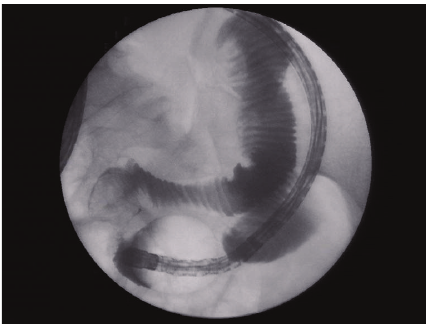
Figure 5: Granular cell tumour with ulcers in the ileum.